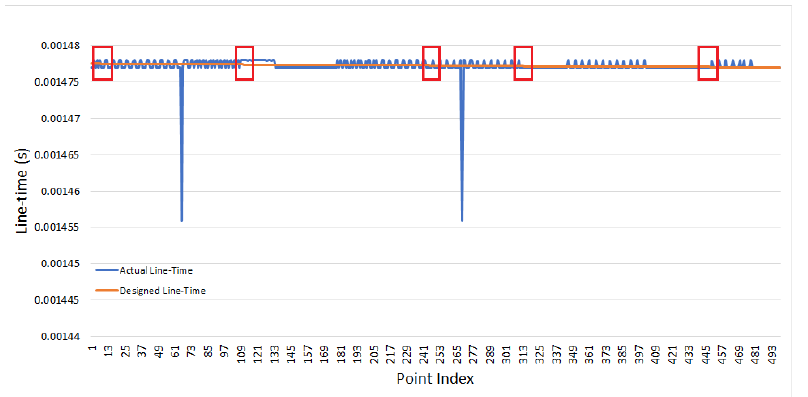
Figure 7. Time differences between the actual line-time and design line-time: ( a ) comparison between the designed and actual line-time of Image Data 1 and ( b ) time differences between the designed and actual line-time of Image Data 1.